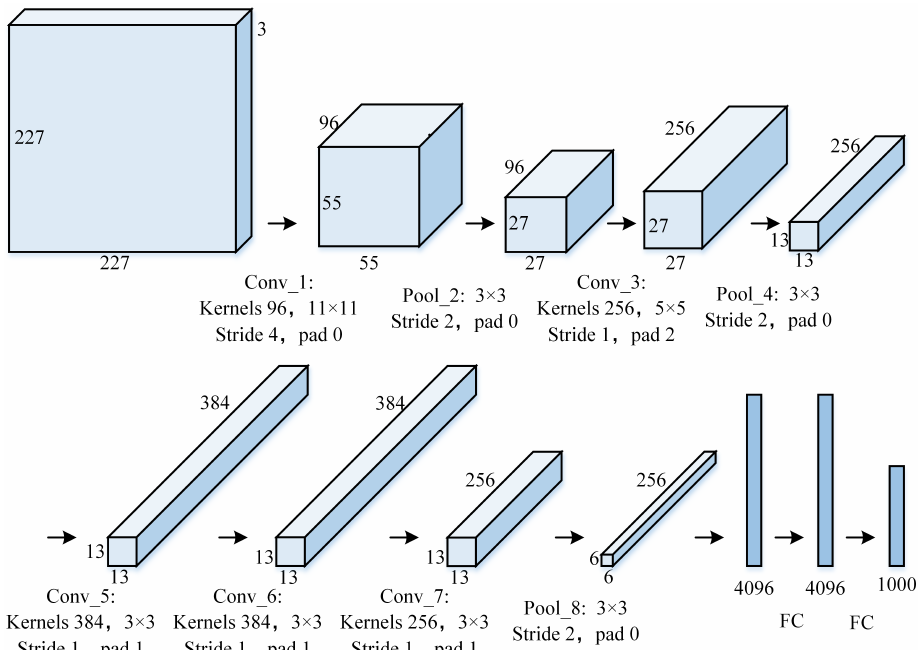
Figure 8. The architecture of the AlexNet network. The convolution size in the first layer is 11 × 11, the second layer is reduced to 5 × 5, and then all 3 × 3 is adopted. Conv_1, Conv_2, and Conv_5 layers are followed by a max-pooling layer with size 3 × 3 and strides 2. Finally, there are two fully connected layers of 4096 and an output layer of 1000 categories.